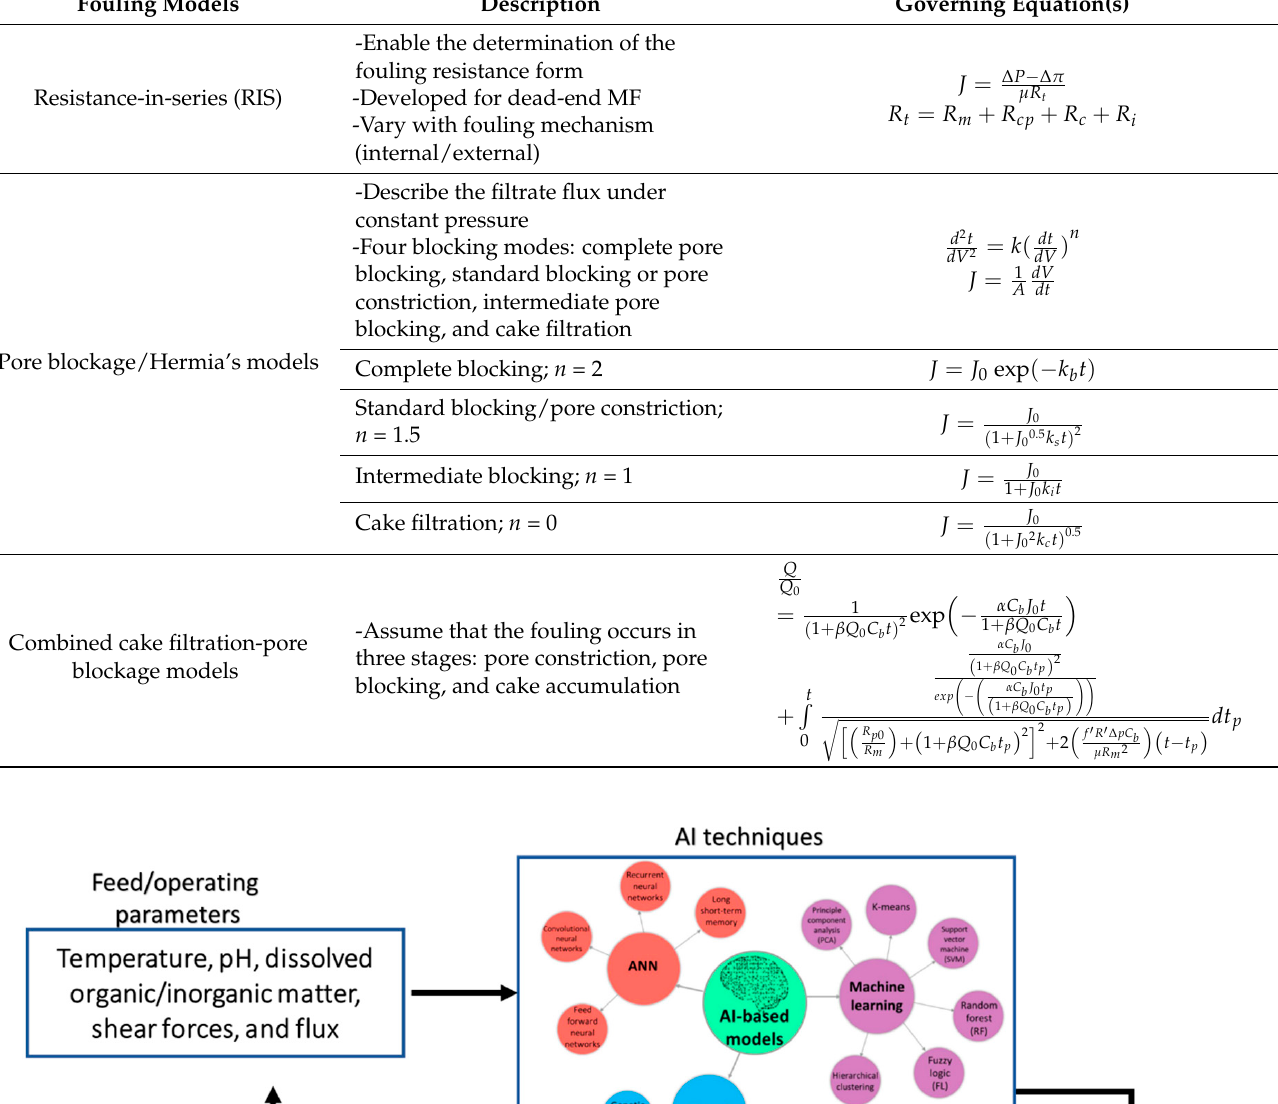
Table 2. Membrane fouling models (adapted from [42–44]).